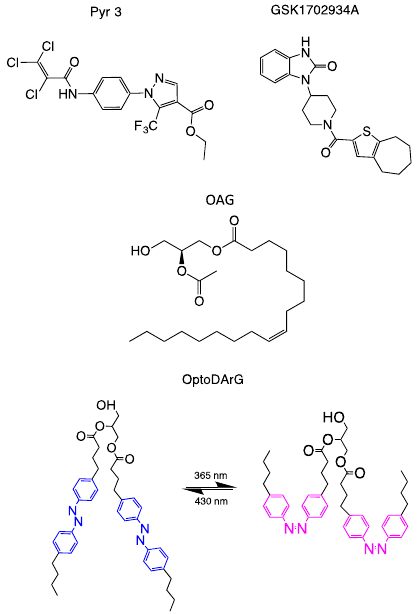
Figure 1. Chemical structures of prototypical antagonist and agonists of transient receptor potential channel 3/6 (TRPC3/6): Pyrazole 3 (Pyr3) as a most commonly used pore blocker; GSK1702934A and 2-Acetyl-1-oleoyl-sn-glycerol (OAG) represent channel agonists (a synthetic, non-lipid activator, and a diacylglycerol/lipid, respectively); OptoDArG as a photochromic agonist (photoswitchable lipid) and a powerful tool for precise control of TRP channels (TRPC) activity.